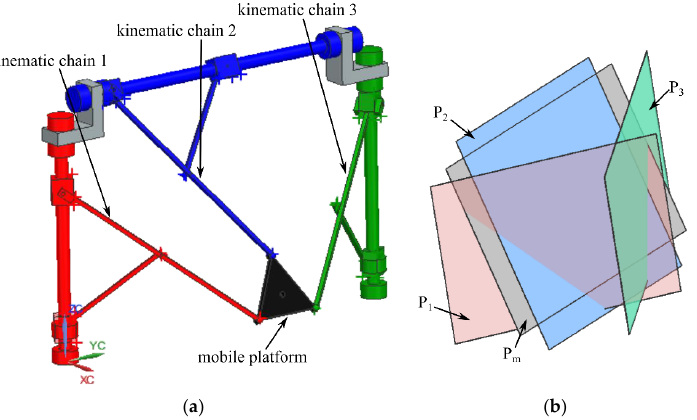
Figure 10. Type II singularity of the 6-DOF parallel robot for SILS (case 5 — one face and the base of the characteristic tetrahedron are coplanar): ( a ) parallel robot pose; ( b ) P 2 and P m are coplanar.